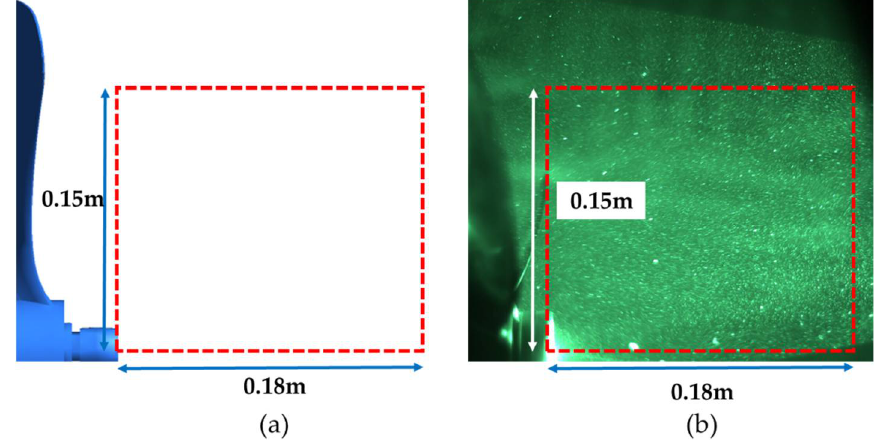
Figure 9. ROIs in CFD simulation ( a ) and PIV experiment ( b ).